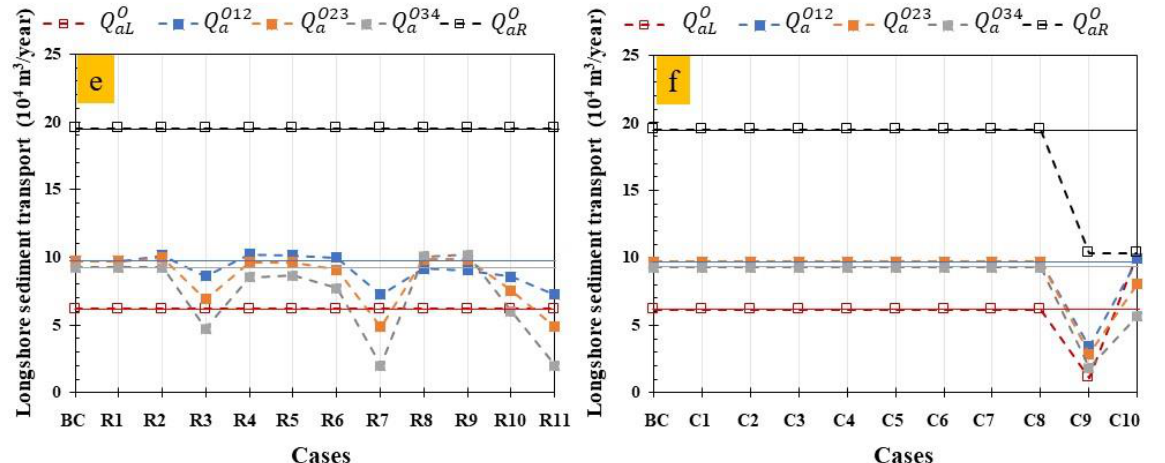
Figure 11. Net sediment transport rate estimated from the sensitivity analysis of sediment budget: ( a ) cross-shore sediment transport (river effect), ( b ) cross-shore sediment transport (coastal effect), ( c ) surf zone sediment transport (river effect), ( d ) surf zone sediment transport (coastal effect), ( e ) offshore zone sediment transport (river effect), and ( f ) offshore zone sediment transport (coastal effect). Sediment transport from the southern boundary (𝑄 𝑎𝐿𝑆 ) and northern boundary ( 𝑄 𝑎𝑅𝑆 ) into the Ishikawa coast, net sediment transport from the southern boundary 𝑄 𝑎𝐿𝑂 and northeastern boundary Q O ) . All the sensitivity analysis cases are represented on the horizontal axis in comparison to the base case. The river effect is shown in the left column, while the coastal effect is shown in the right